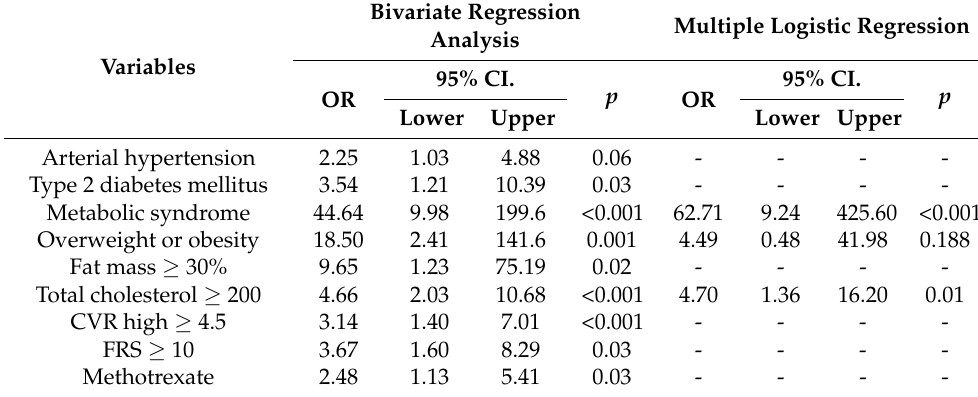
Table 3. Logistic regression showing the odds ratio of the hypertriglyceridemic waist with cardiovas- cular risk